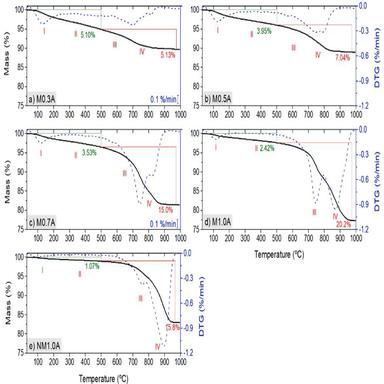
TGA-DTG curves of magnetic products of fine recycled mixed aggregates (high carbonate content sample).